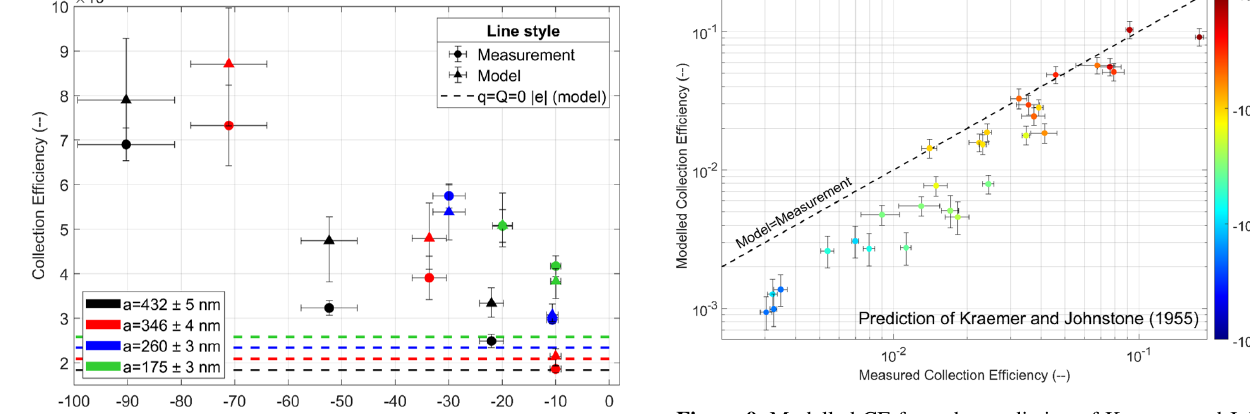
Figure 9. Modelled CE from the prediction of Kraemer and John- stone (1955) as a function of the measured CE. The droplet radius is 48 . 5 ± 1 . 1µm. Only the negative charge products for the four AP radii are considered here, represented by the colour code. The ex- perimental conditions are summarised in Table